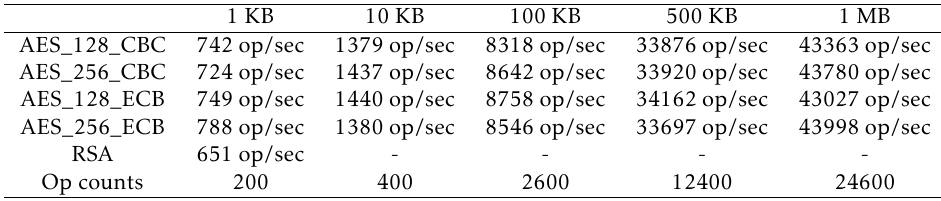
Table 3. Read/write frequency during batch file encryption.